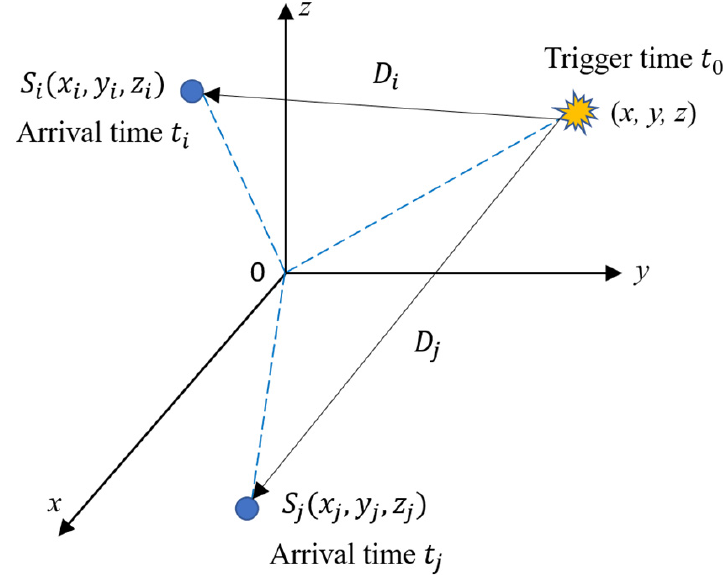
Figure 1. Spatial diagram illustrating the variables defined in the proposed method.